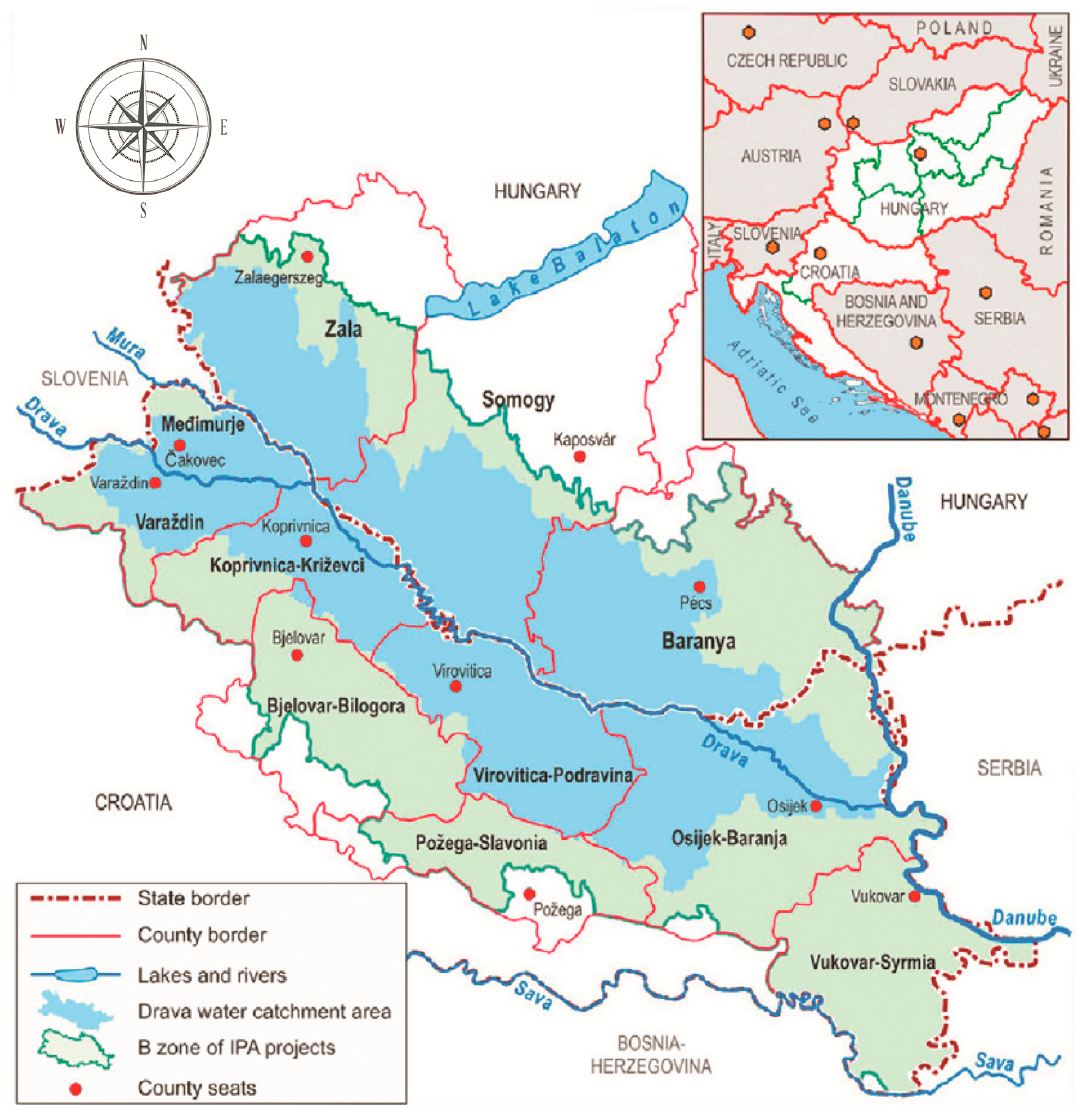
Figure 1. Croatian-Hungarian border regions [3].